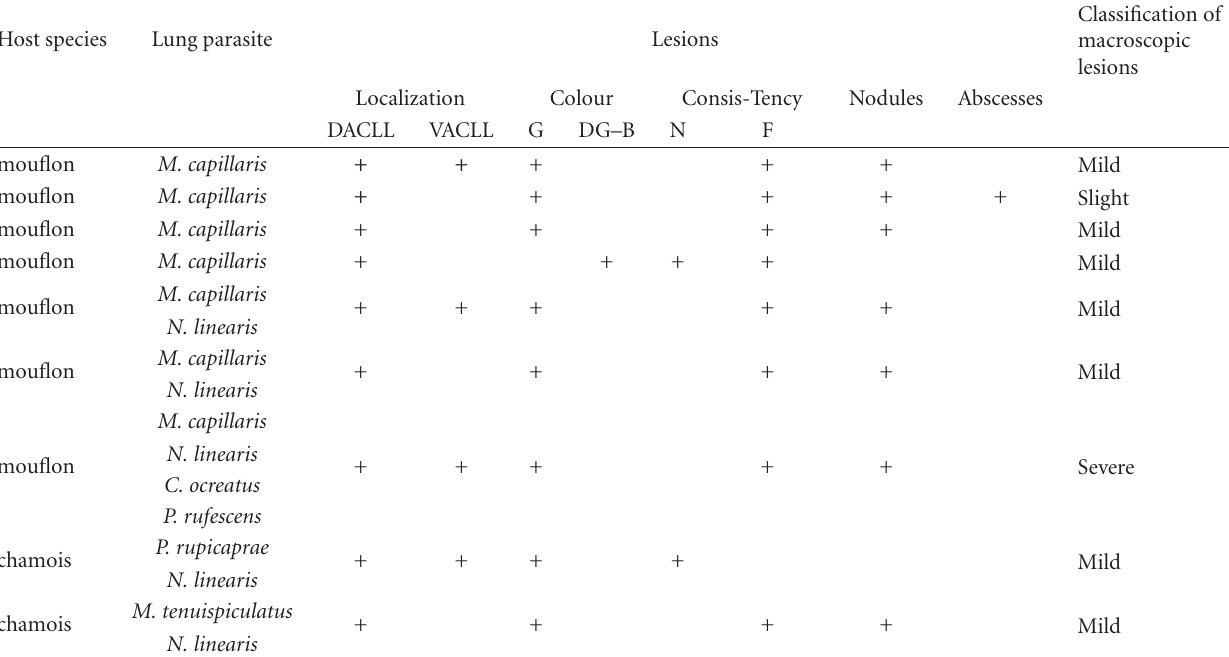
Table 3: Macroscopic lesions and classification of the lung change severity in mouflons and chamois with natural protostrongylid infections. Host species